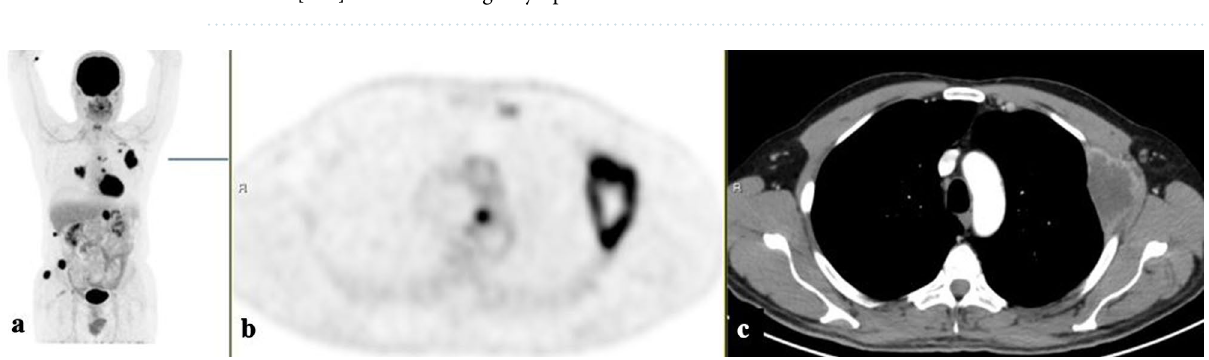
Figure 1. [18F]FDG-PET/CT: maximum intensity projection (MIP), (a) representative PET (b) and CT (c) axial slices. A 65-year-old woman with a biopsy-proven squamous cell carcinoma from a pelvic mass (A. b). Left obturator [18F]FDG avid enlarged lymph nodes.